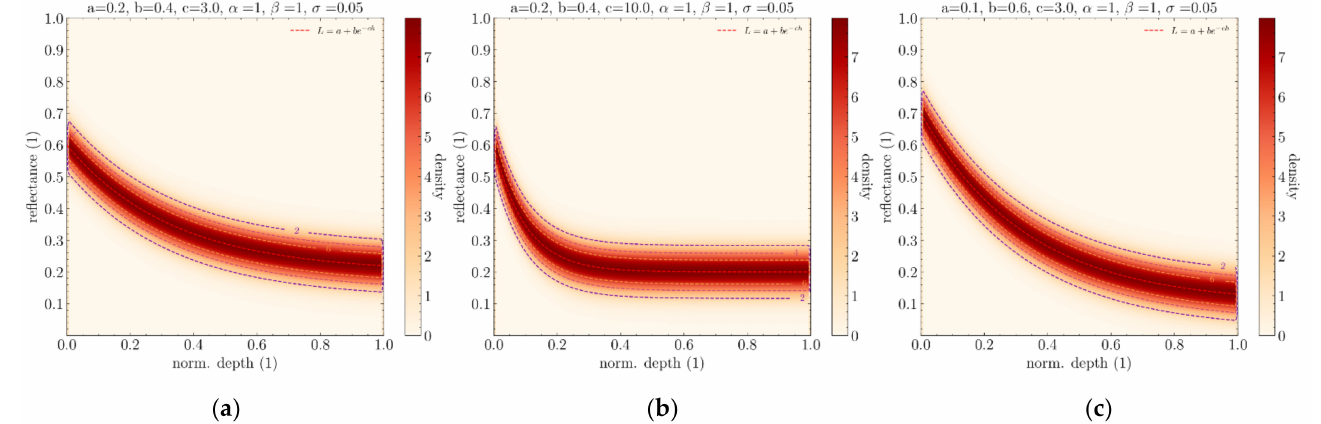
Figure 10. Influence of parameters a, b, and c from Lyzenga’s equation. ( a ) Simple instance of BNP. ( b ) Same BNP with higher attenuation coefficient c. ( c ) Same BNP but with different parameters a and b.